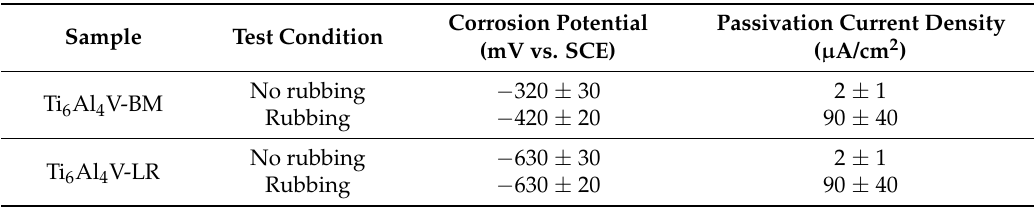
Table 3. Corrosion potential and passivation current density of Ti 6 Al 4 V-BM and Ti 6 Al 4 V-LR samples obtained from polarization curves.